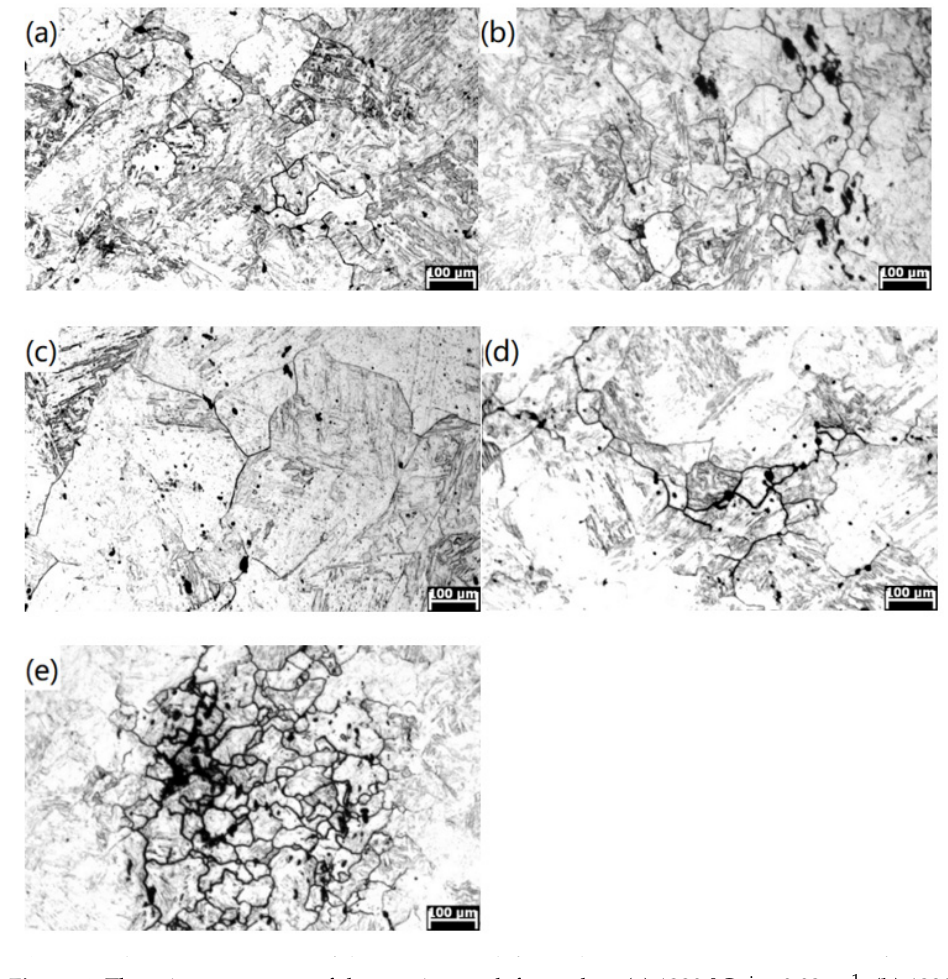
. ε = 0.02 s − 1 ; ( b ) 1230 ◦ C, . ε = 0.002 s − 1